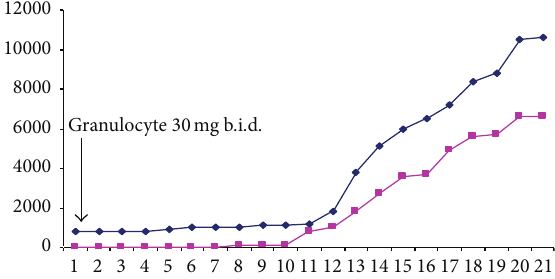
Figure 2: The course of the patient’s white blood cell and leukocyte count during granulocyte treatment; blue line: white blood cell count, pink line: leukocyte cell count; b.i.d.: twice a day.